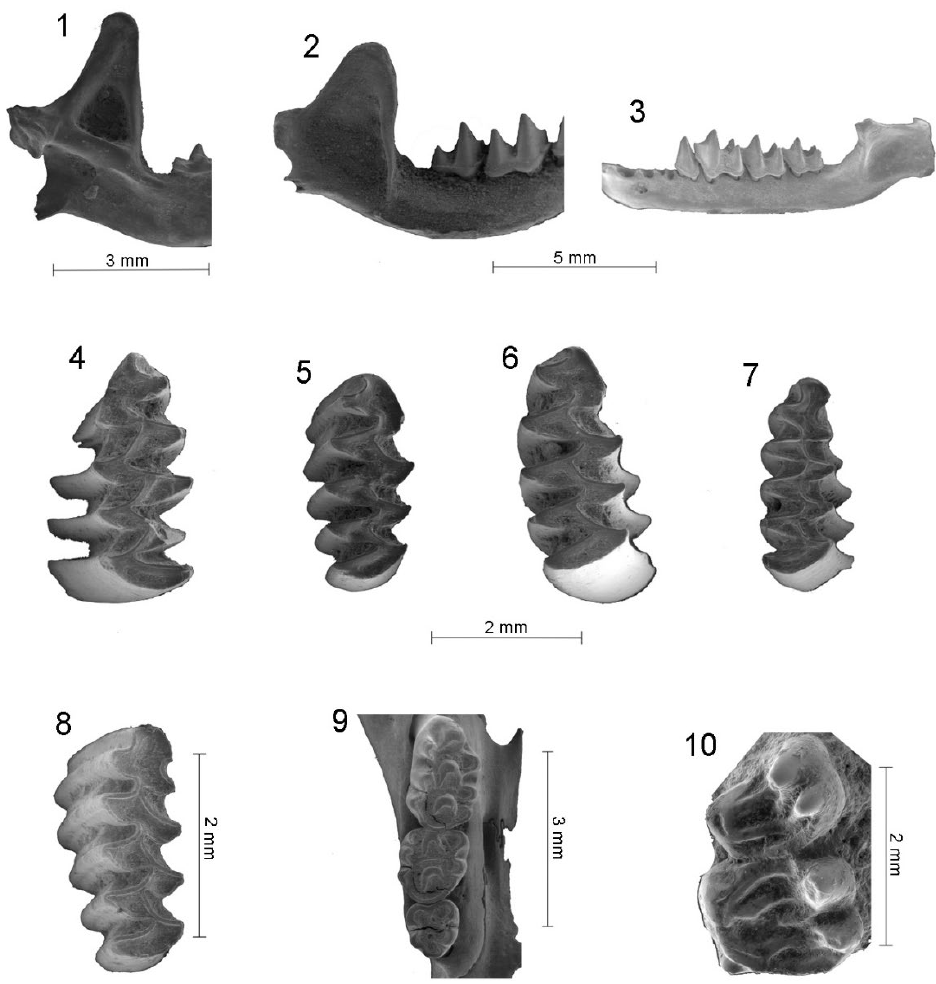
Figure 7. Some small mammal remains identified from Cova del Gegant. ( 1 ): Right mandible of Crocidura russula (lingual view). ( 2 ): Right mandible of Myotis myotis (buccal view). ( 3 ): Left mandible of Miniopterus schreibersii (buccal view). ( 4 – 6 ): One left, two right m1 of Microtus ( Iberomys ) cabrerae (occlusal view). ( 7 ): Right m1 of Microtus agrestis (occlusal view). ( 8 ): m1 right Microtus ( Terricola ) duodecimcostatus (occlusal view). ( 9 ): Right M1-M3 of Apodemus sylvaticus (occlusal view). ( 10 ): Left P4–M1 of Eliomys quercinus (occlusal view). ESEM (Environmental Scanning Electron Microscope) images of mandibles 1 to 3 showing diagnostic criteria for taxonomic identification.